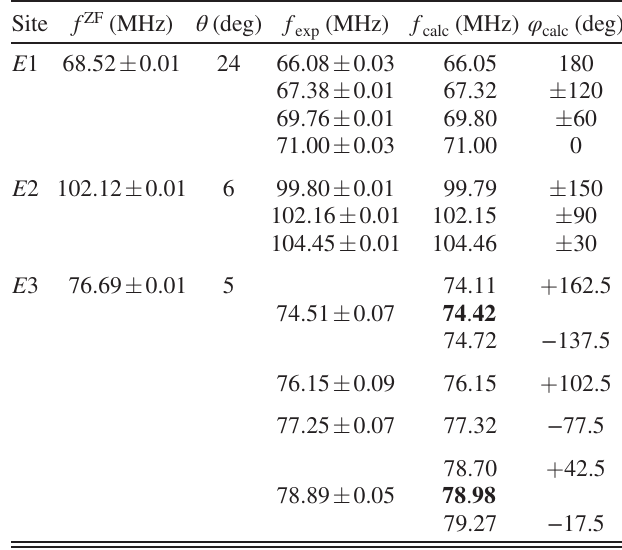
TABLE IV. Comparison of frequencies f 2.2 K in 20 mT ⊥ c and calculated values f Eq. (A2) using f ZF from Fig. 1(c), θ from Table III, φ given by 0 ° þ δ ; (cid:4) 60 ° þ δ ; (cid:4) 120 ° þ δ and 180 ° þ δ with δ ¼ 0 ° for E 1 , δ ¼ 30 ° for E 2 , and δ ¼ 17 . 5 ° for E 3 . Bold values correspond to the average of vertically adjacent